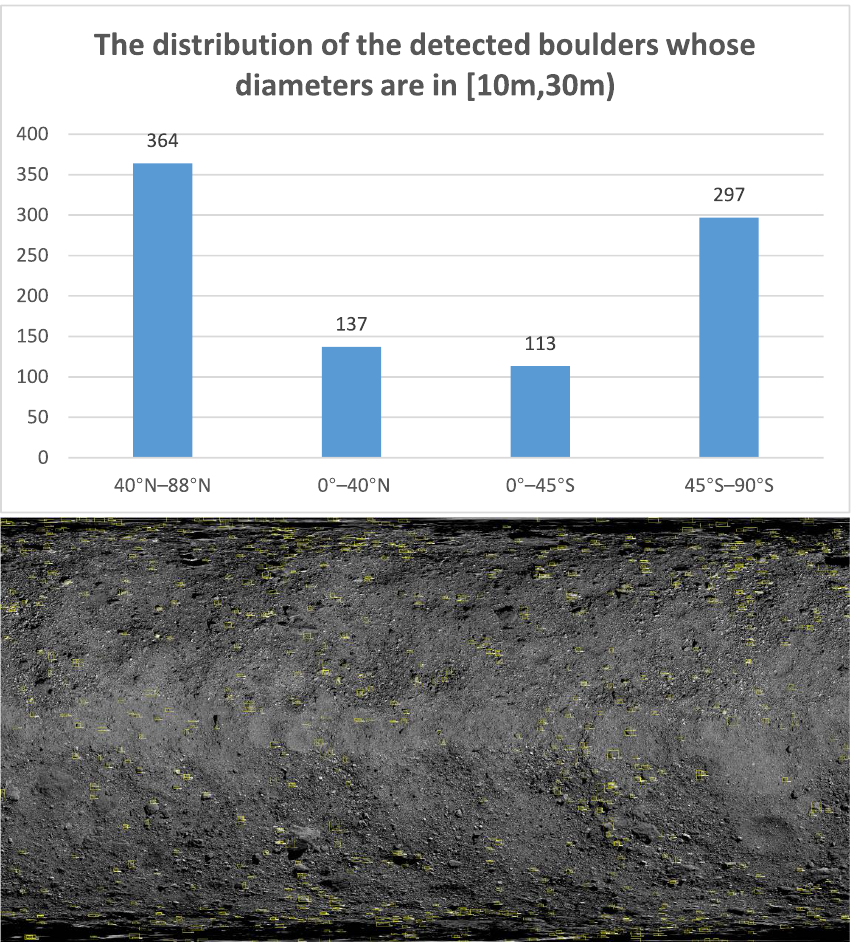
Figure 9. The distribution of the detected boulders whose diameters are between 10 m and 30 m in each region.